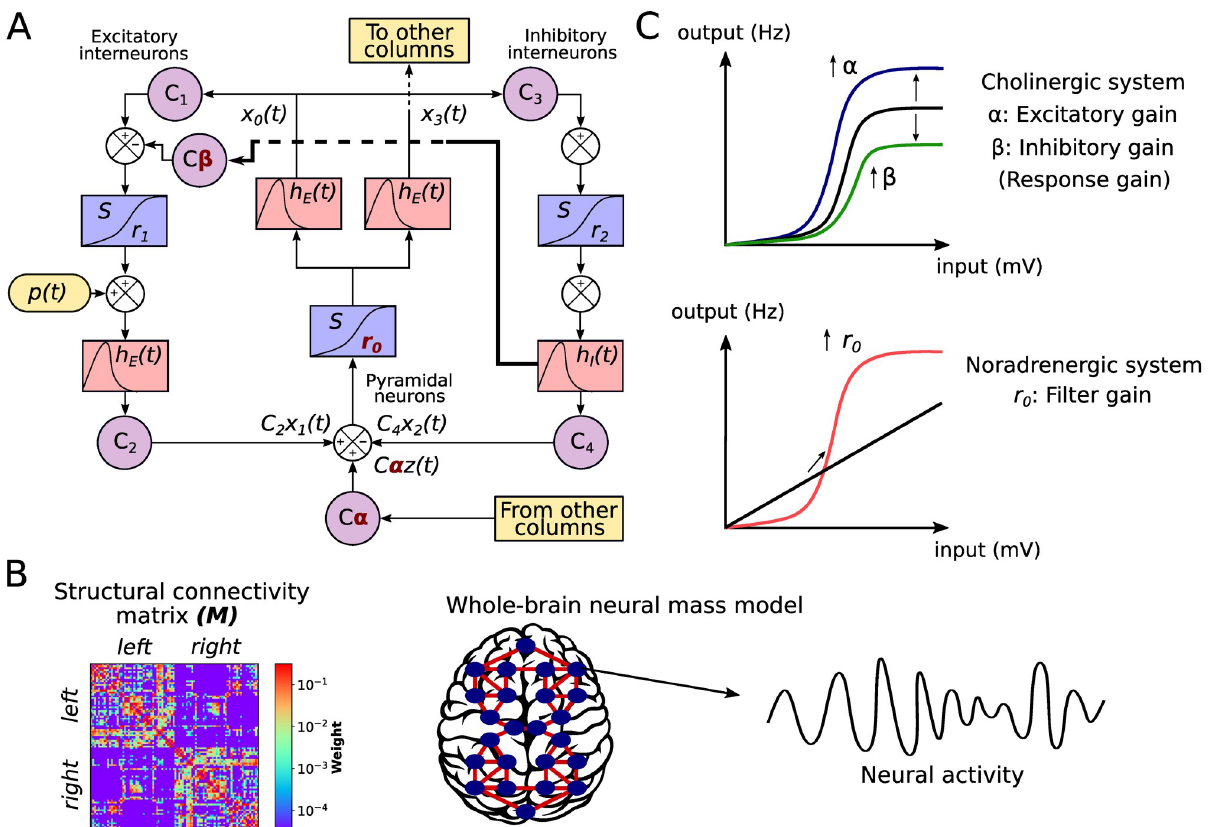
Fig 1. Whole-brain neural mass model. A) The Jansen & Rit model is constituted by a population of pyramidal neurons with excitatory and inhibitory feedback mediated by interneurons (INs). Each population is connected by a series of constants C i . The outputs are transformed from average pulse density to average postsynaptic membrane potential by an excitatory (inhibitory) impulse response function h E ( t ) ( h I ( t )). Then, a sigmoid function S performs the inverse operation. Pyramidal neurons project to distant cortical columns, and receive both uncorrelated Gaussian-distributed inputs p ( t ) and inputs from other cortical columns z ( t ). Neuromodulation is constituted by three parameters, colored in red: excitatory gain α , which scales z ( t ), inhibitory gain β , which increases the inhibitory input to excitatory INs (thick line), and filter gain, r 0 , which modifies the slope of the sigmoid function in pyramidal neurons. B) Each node represents a cortical column, whose dynamics is ruled by the Jansen & Rit equations. Nodes are connected through a structural connectivity matrix, M C) Neuromodulation modifies the coupling between neurons and the properties of the input (average postsynaptic membrane potential) to output (average pulse density) sigmoid function. The cholinergic system modifies the global coupling and local inhibition. α amplifies the response of pyramidal neurons to other columns’ input; it also increases pyramidal neurons excitability. β amplifies the effect of inhibitory INs to excitatory INs, damping pyramidal cells excitability. The noradrenergic system increments the responsivity of pyramidal neurons to relevant stimuli respect to noise, as a filter, by increasing the slope r 0 of their sigmoid function.